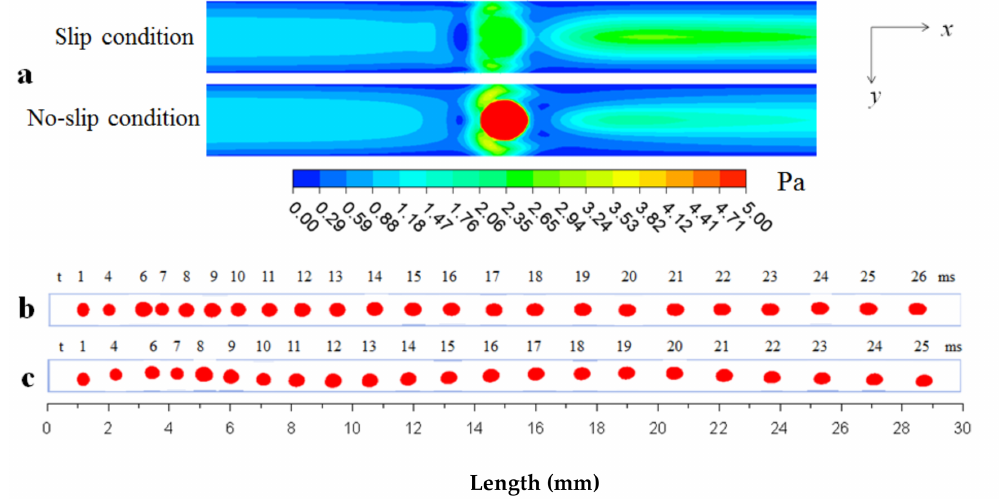
Figure 7. Comparisons of water transport in the flow channel: ( a ) wall shear stress at the MEA surface between the simulations with slip (the conventional case in Table 1) and no-slip boundary conditions at 14 ms; ( b ) water spreading on the MEA surface for D = 0 with the no-slip condition; ( c ) water spreading on the MEA surface for D = 0.15 mm with the no-slip condition. Other conditions are the same, with the corresponding slip cases given in Table